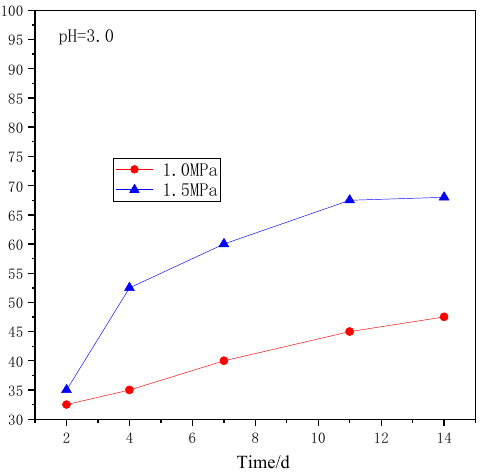
Figure 16. Variation in leaching rate with oxygen pressure (pH = 3.0).